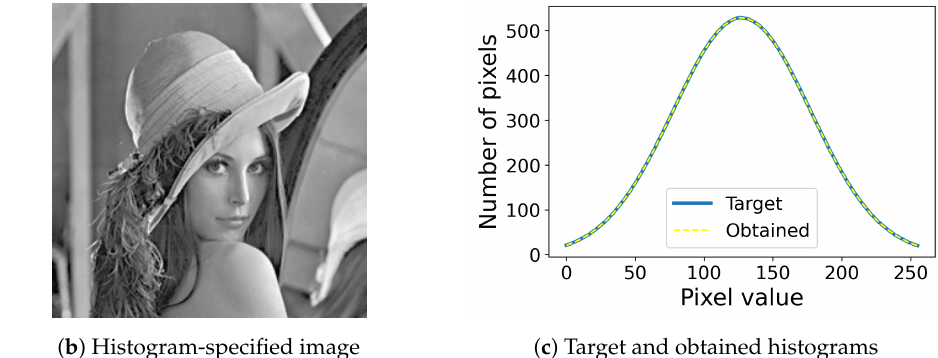
Figure 4. Nikolova and Steidl’s exact histogram specification: ( a ) the output u ( T ) of Algorithm 1 is visualized as an 8-bit grayscale image; ( b ) the output image; ( c ) Gaussian target (blue solid line) and obtained (yellow dashed line)